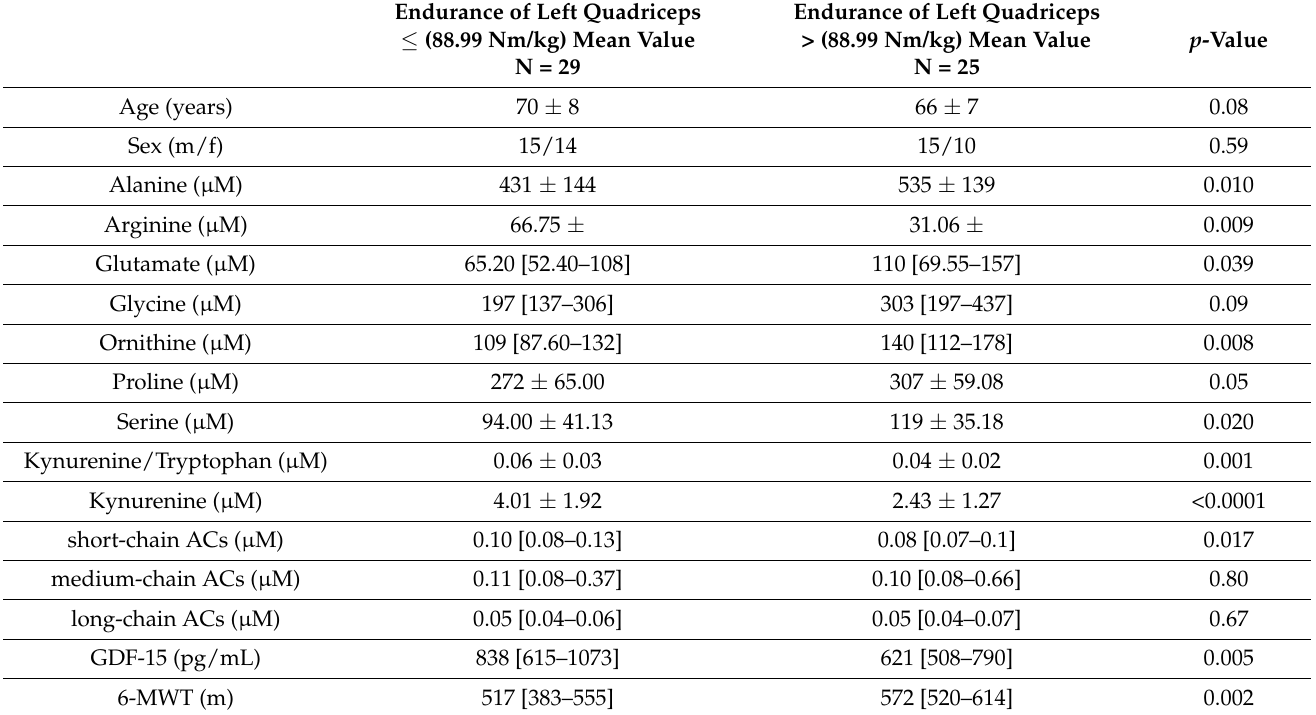
Table 2. Metabolomic and clinical profile of patients with HF and reduced vs. normal muscle endurance. Endurance of Left